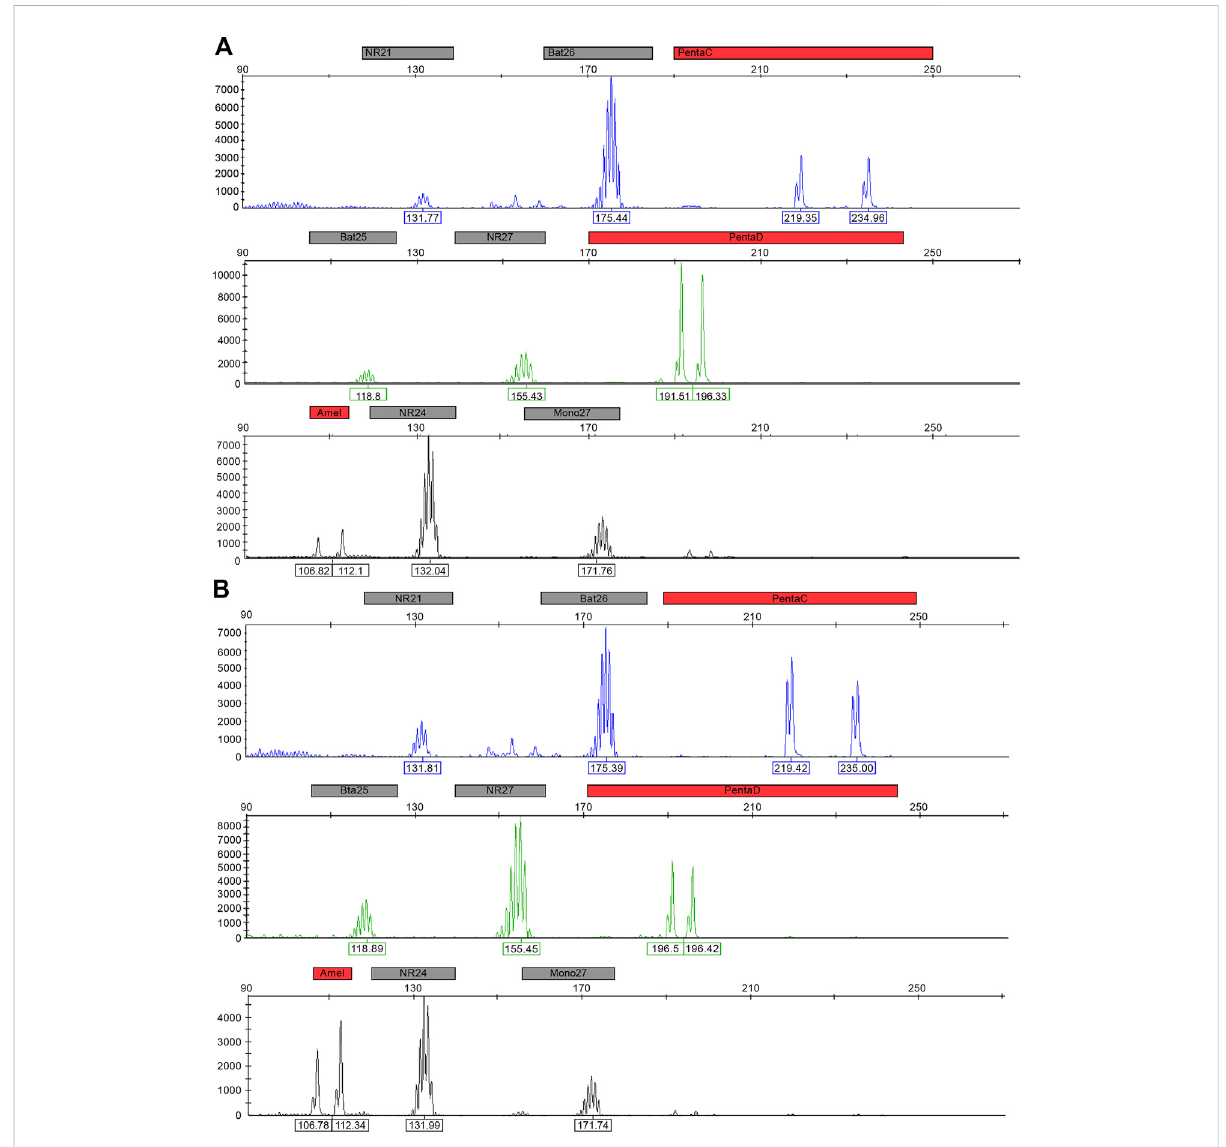
FIGURE 6 FluorescentPCR-capillaryelectrophoresisdetectingMSIandSTRlocusmaptyping. (A) .Maptypingofpheochromocytomaandparaganglioma. (B) . Map typing of normal